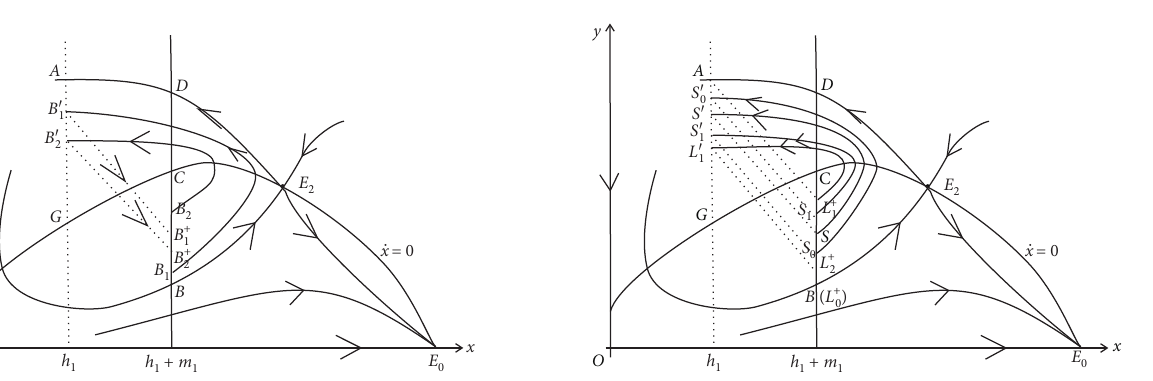
Figure 3: Uniqueness of order-1 periodic orbit of system (11) when p 0 < p < p ∗ .